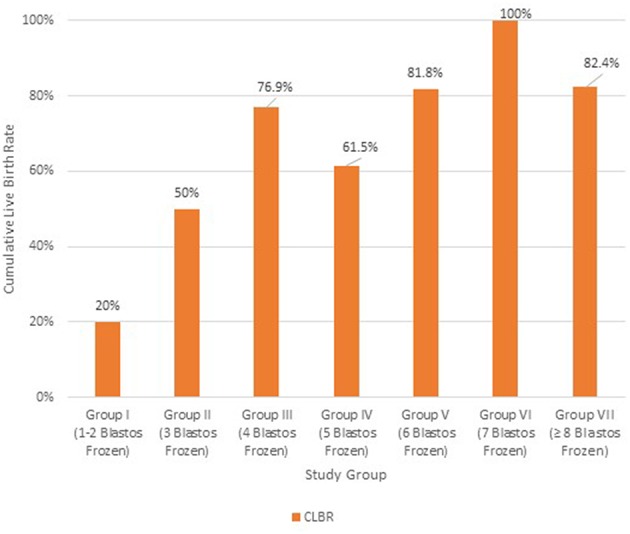
Cumulative Live Birth Rate (CLBR) in each group of patients according to the absolute number of vitrified blastocysts; Group I: 1–2 blastocysts frozen (n = 50); Group II: 3 blastocysts frozen (n = 20); Group III: 4 blastocysts frozen (n = 26); Group IV: 5 blastocysts frozen (n = 26); Group V: 6 blastocysts frozen (n = 22); Group VI: 7 blastocysts frozen (n = 32); Group VII: ≥8 blastocysts frozen (n = 68).